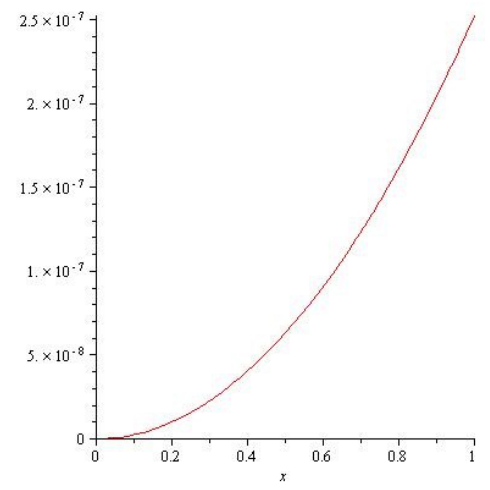
Figure 6. The error plot of Example 3, at γ =